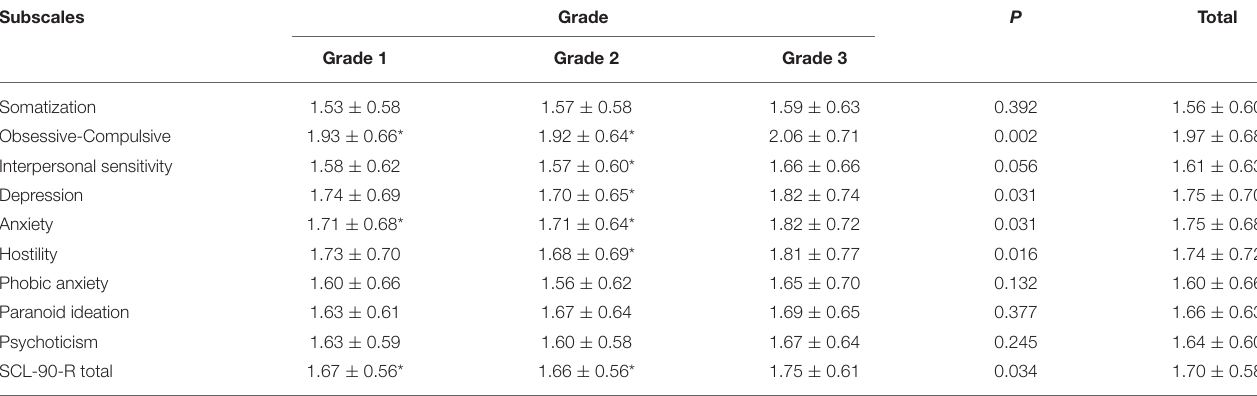
TABLE 4 | Comparison of standardized scores of each subscale of SCL-90-R among different grade abbreviation expansions ( x ± s ).